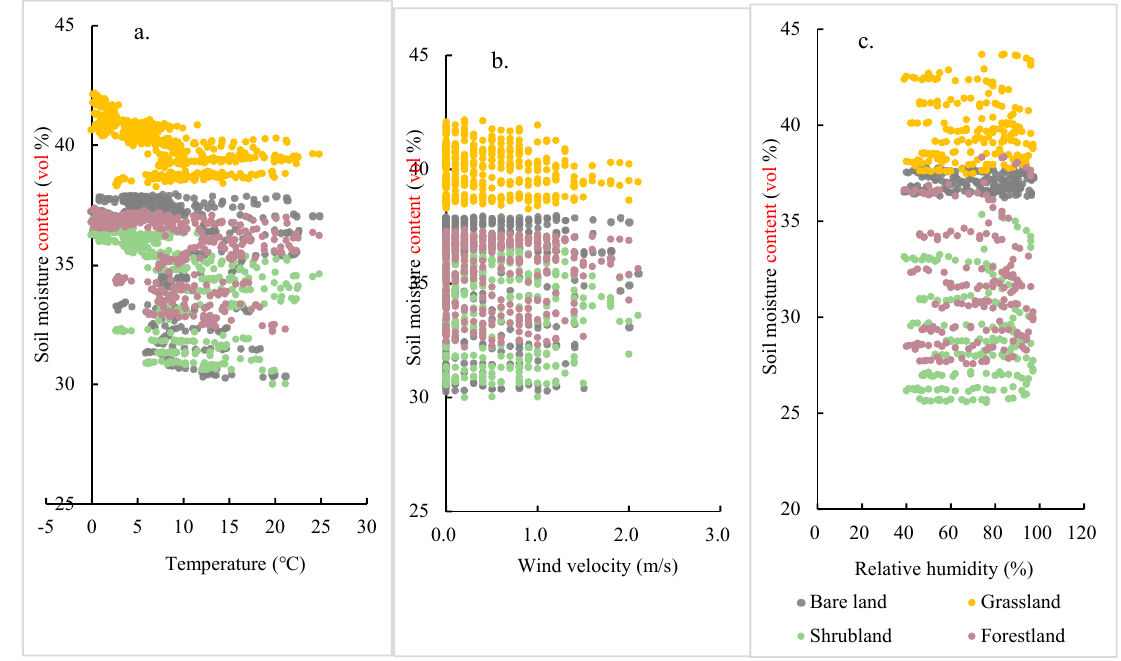
Figure 12. Volumetric soil moisture content, with temperature ( a ) and wind velocity ( b ) in a continuous period without rainfall in the dry season, and with relative humidity in a period with little rainfall in the rainy season ( c ). Table 15. Results of the Spearman correlation analysis and the significance level of the relation between volumetric soil moisture content and temperature and wind velocity in a continuous period without rainfall in the dry season, and relative humidity in a period with little rainfall in the rainy season.